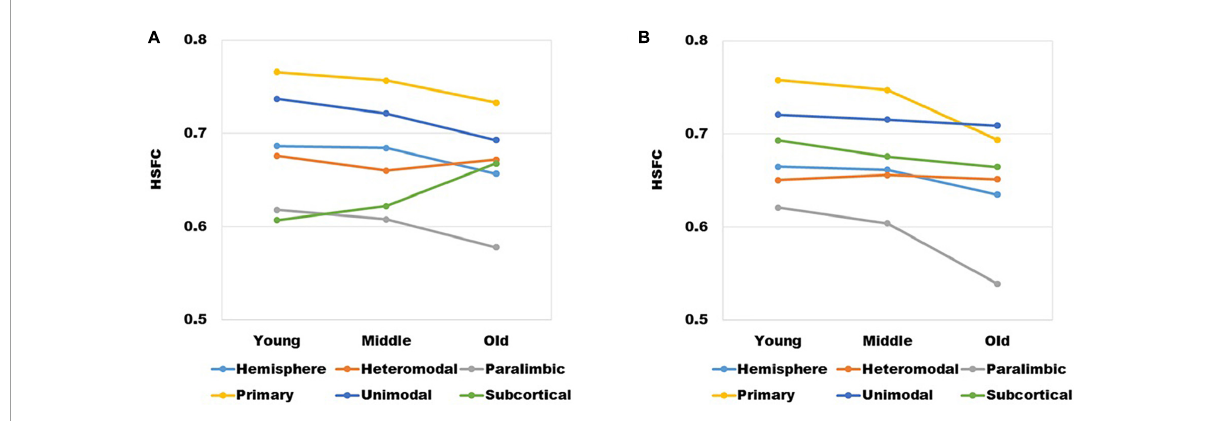
FIGURE6 (A) The changes of HSFC with GSR obtained by BNA and (B) the changes of HSFC with NGSR obtained by AICHA in different age groups and